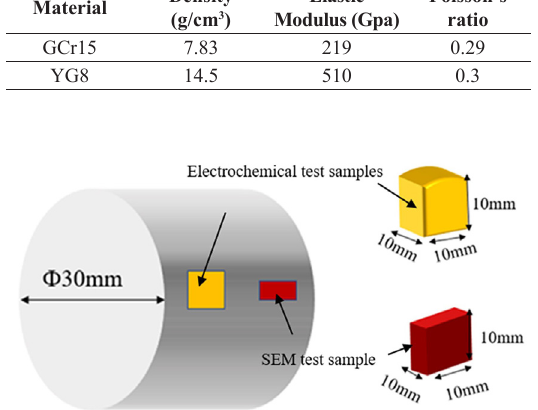
Figure 3. Schematic diagram of electrochemical experiments and SEM specimen